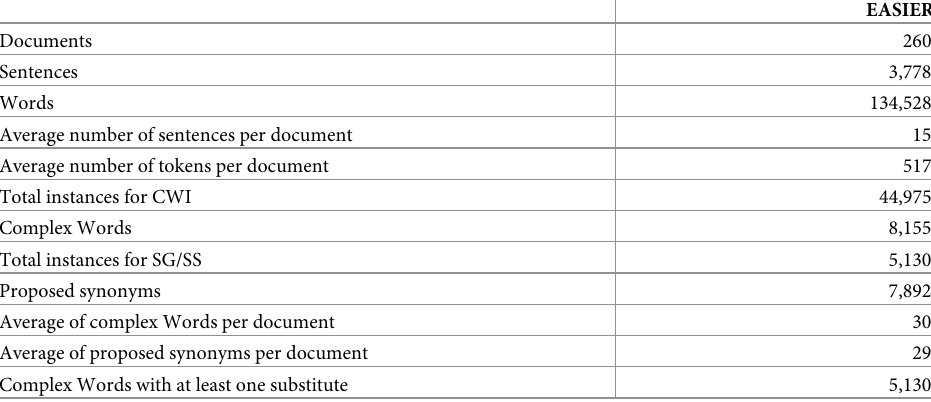
Table 3. EASIER corpus